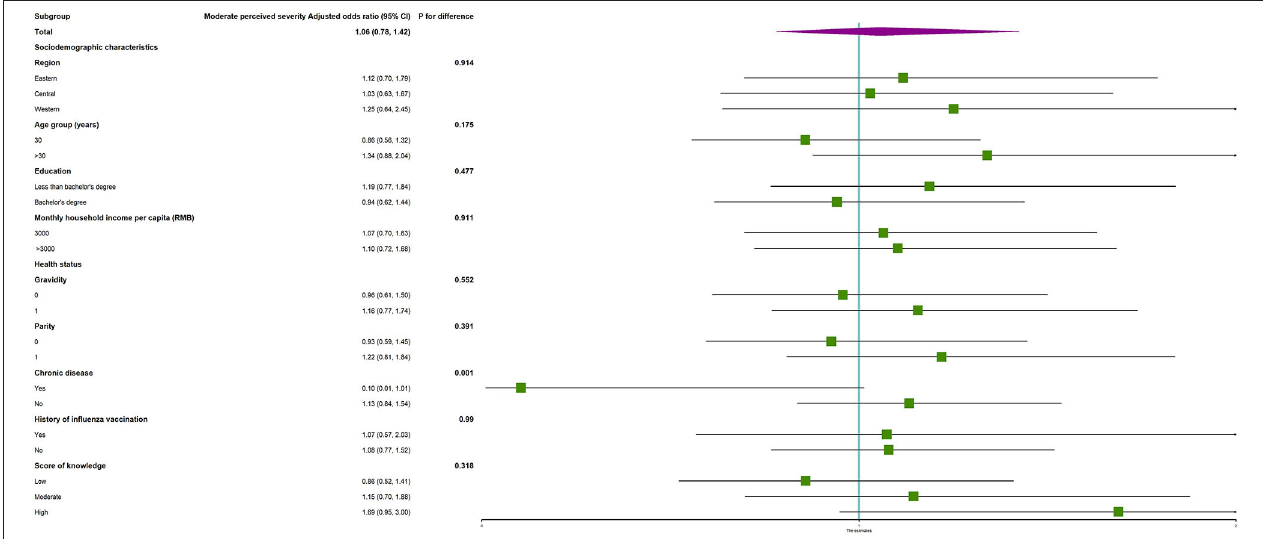
FIGURE 1 | The subgroup analysis on the association between risk perception and the risk of COVID-19 vaccine hesitancy to children among reproductive women with moderate perceived severity.